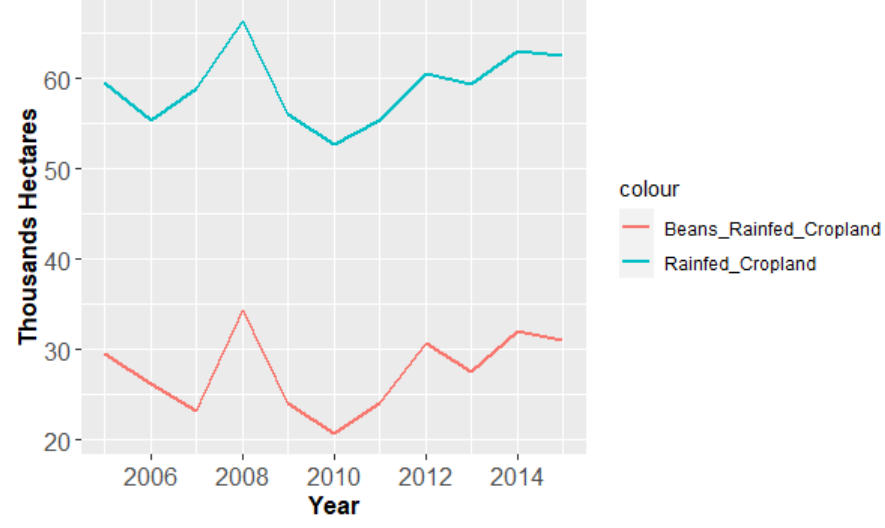
Figure 5. Areas of extant rainfed cropland and beans rainfed cropland in Cabo Verde, from 2005 to 2015 [33,35].